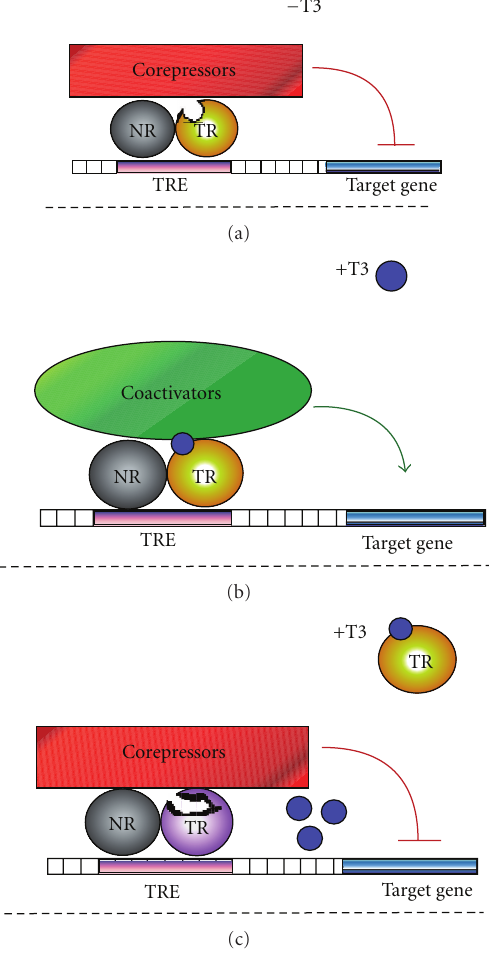
Figure 3: Transcriptional activity of wild-type and dominant- negative TRs. (a) In the absence of T3, wild-type TR (orange sphere plus a grey homo- or heterodimer partner) binds to thyroid hormone response elements (TREs-, shown as pink rectangle on DNA), recruits a cohort of corepressor proteins (shown as a red rectangle), and represses transcription of a given target gene (blue rectangle). (b) In the presence of T3 (dark blue sphere), wild-type TRs undergo a conformational change and exchange corepressor proteins for coactivators (green oval) to activate transcription of a target gene. (c) Dominant-negative TR mutants (shown here as a disfigured lavender sphere) have defects in hormone binding, corepressor release, or coactivator recruitment and consequently repress transcription even in the presence of hormone and other wild-type